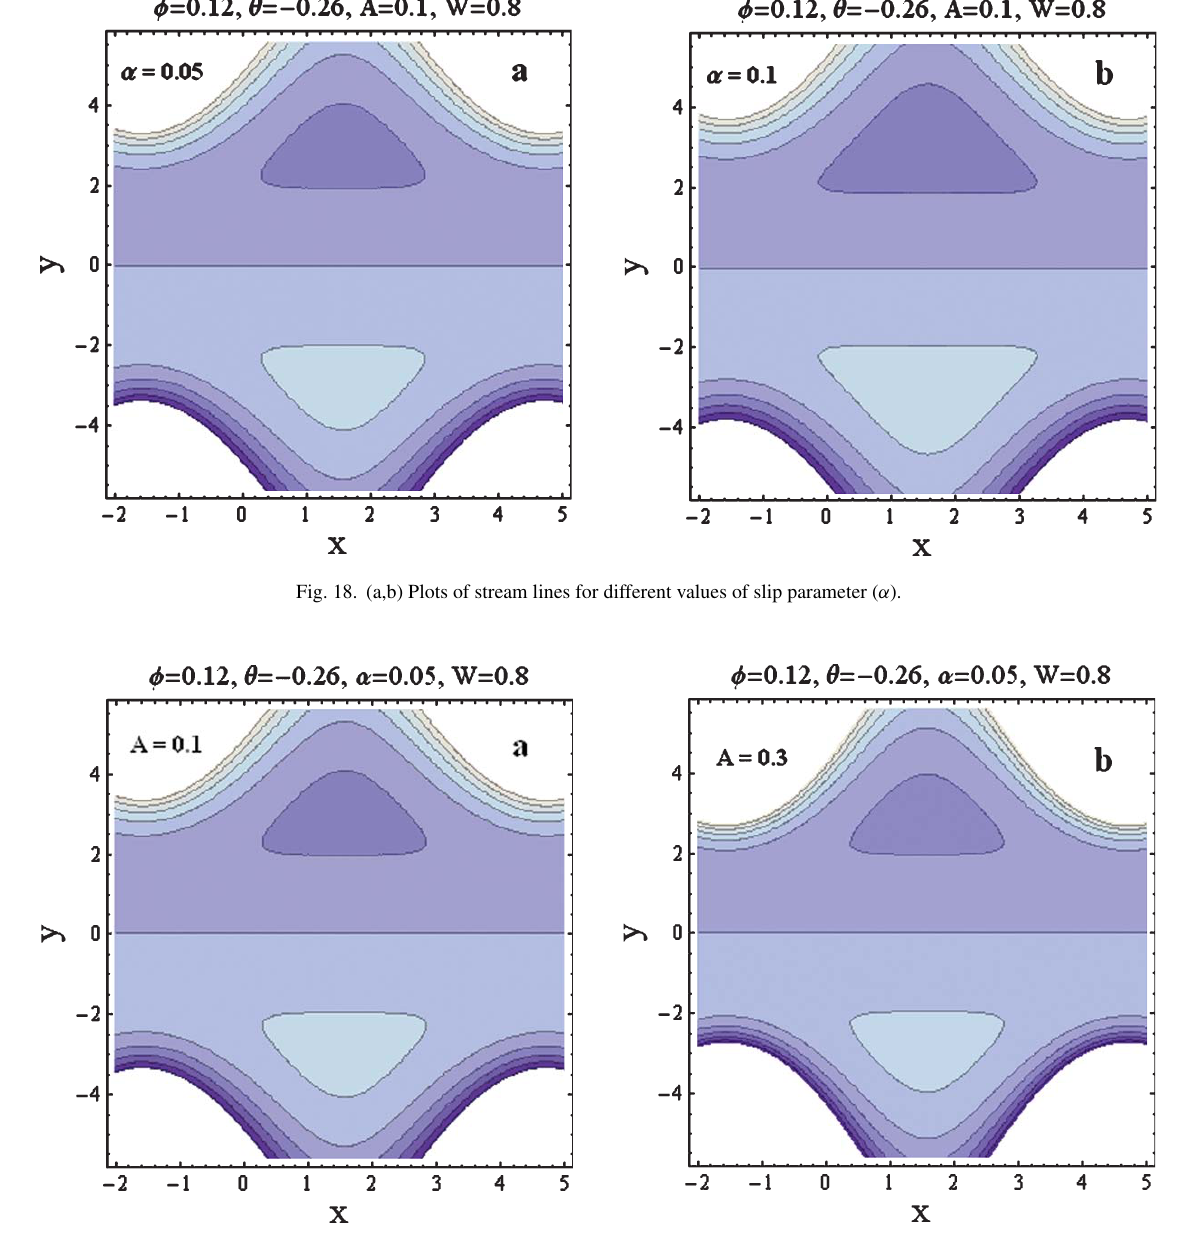
Fig. 19. (a,b) Plots of stream lines for different values of fluid parameter ( A